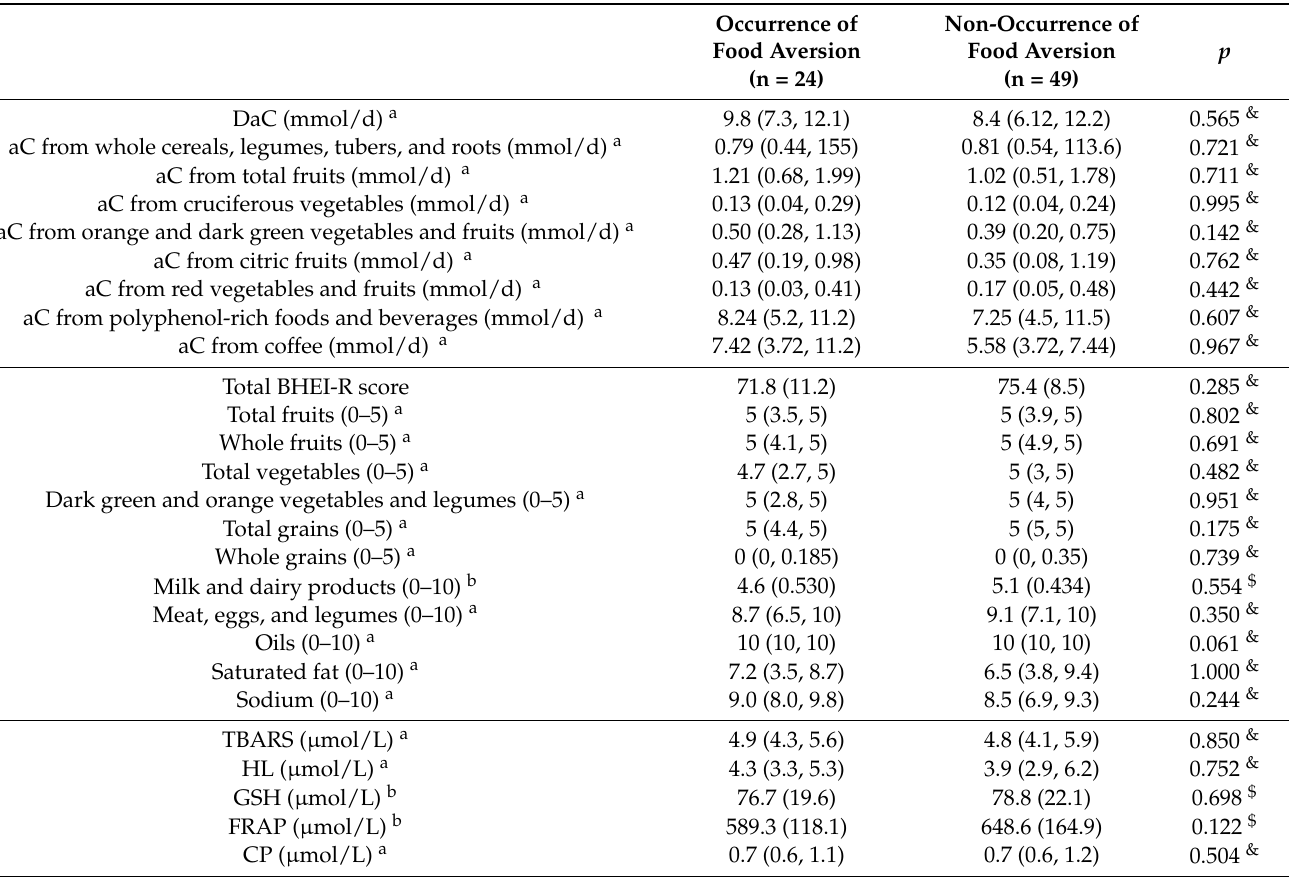
Table 2. Differences in baseline dietary antioxidant capacity (DaC), antioxidant capacity (aC) from food groups and coffee, Brazilian Healthy Eating Index—Revised (BHEI-R) total scores and compo- nents, and oxidative stress biomarkers between women with the occurrence of food aversions and non-occurrence of food aversion during adjuvant chemotherapy for breast cancer (n = 73). Non-Occurrence of Occurrence of Food Food Aversion